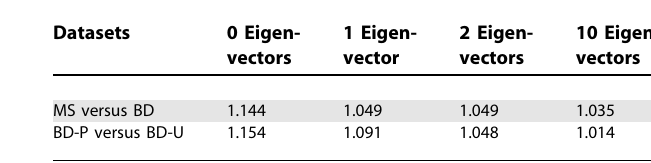
Table 2. Values of Genome-Wide Inflation Factor ( k ) for Two Comparisons of Genome-Wide Datasets, Correcting along 0, 1, 2, or 10 Eigenvectors Using EIGENSTRAT